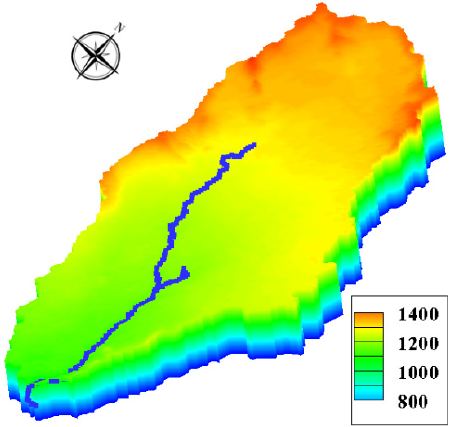
Figure 2. The elevation (in meters) contour of the studied